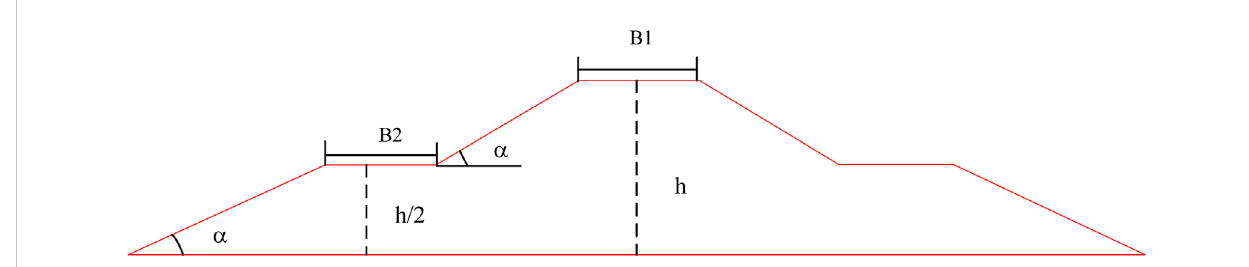
FIGURE 3 The primary section of the concentrated full tailings structure.